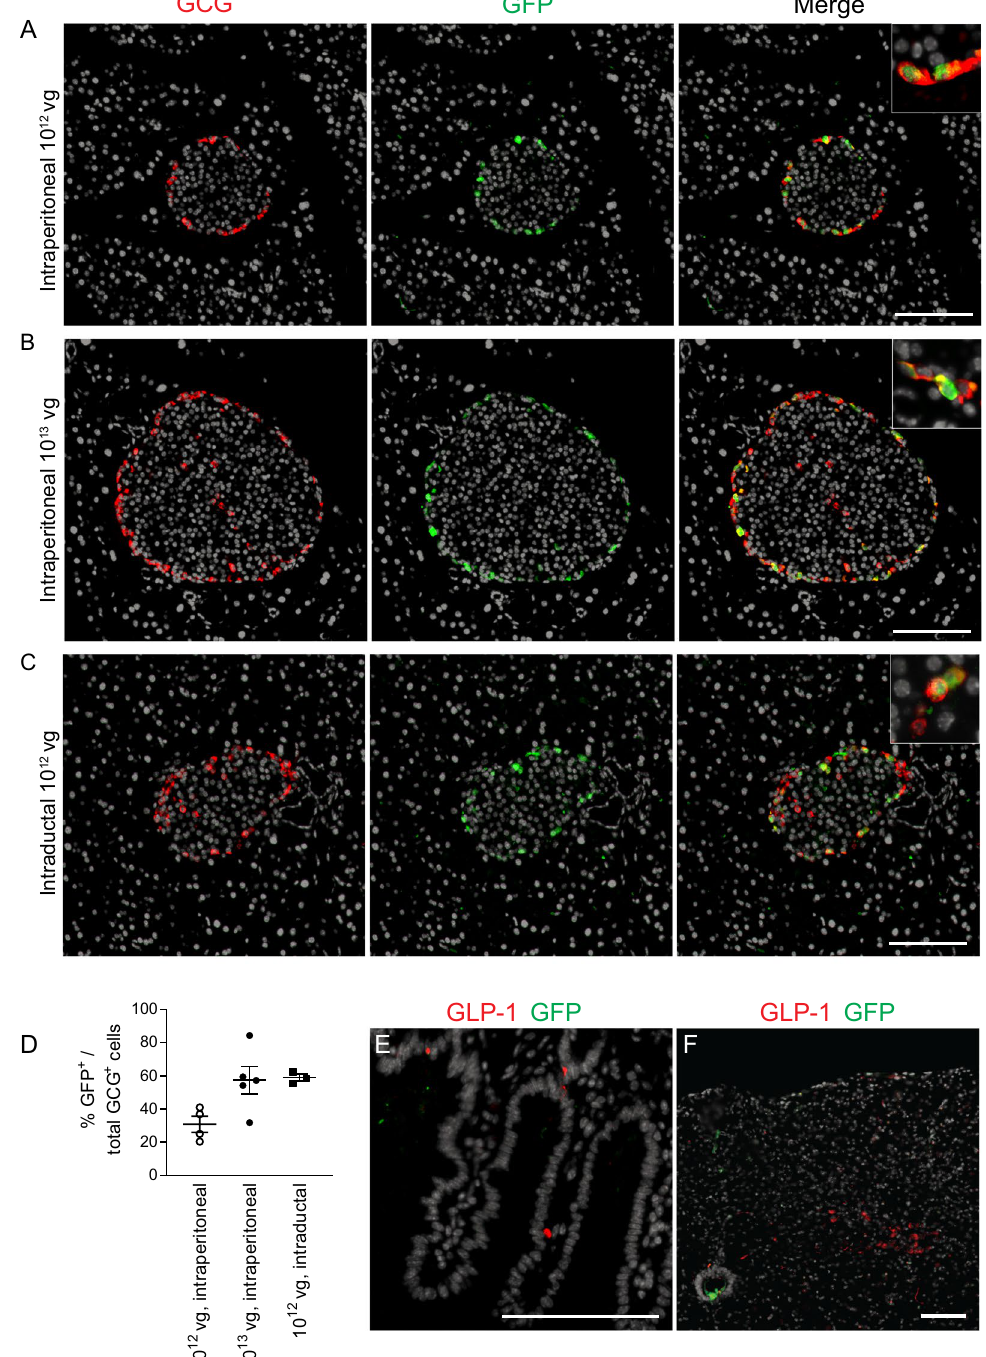
Figure 1. AAV GCG-EGFP leads to α -cell EGFP expression. Pancreas sections from adult C57BL/6 mice treated with AAV GCG-EGFP by ( A ) single intraperitoneal injection of 10 12 vg, ( B ) single intraperitoneal injection of 10 13 vg, and ( C ) single intraductal injection of 10 12 vg. Glucagon (red), GFP (green), and DAPI (grey). ( D ) Quantification of cells with colocalization of both GFP and GCG as a ratio of total GCG-positive cells, from pancreas sections. ( E ) Small intestine section and ( F ) brainstem section at the level of the solitary tract nucleus, stained for GLP-1 (red), GFP (green), and DAPI (grey), from a mouse treated with 10 13 vg of AAV GCG-EGFP by single intraperitoneal injection. Non-specific GFP staining can be seen in the lumen of the central canal in brainstem sections. Scale bars = 100 μ m. AAV: adeno-associated virus; GCG: glucagon; GFP: green fluorescent protein; GLP-1: glucagon-like peptide